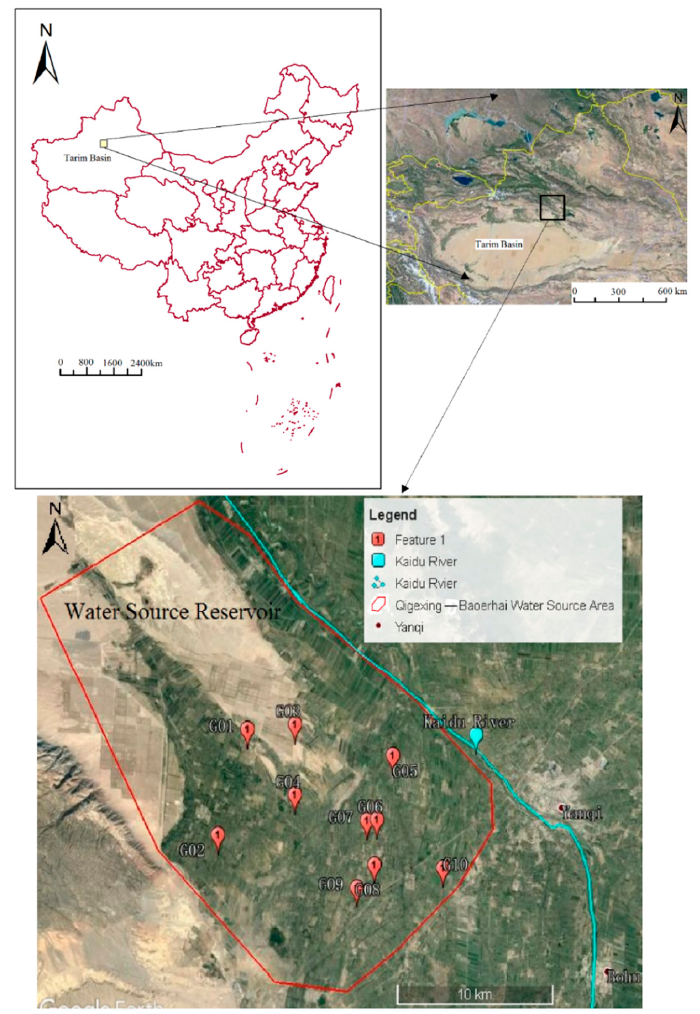
Figure 1. Location of the study area.